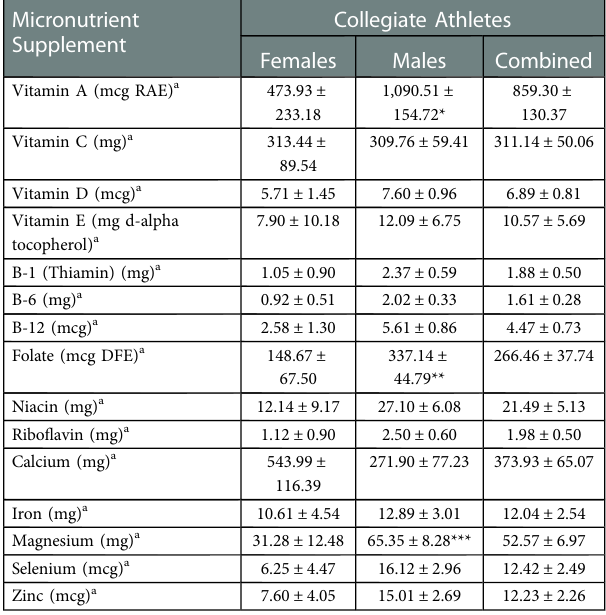
TABLE 2 Micronutrient supplementation among female and male collegiate